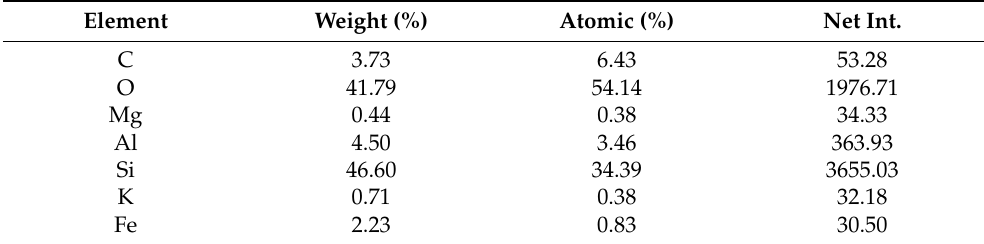
Table 4. Weight % of elements in quartz